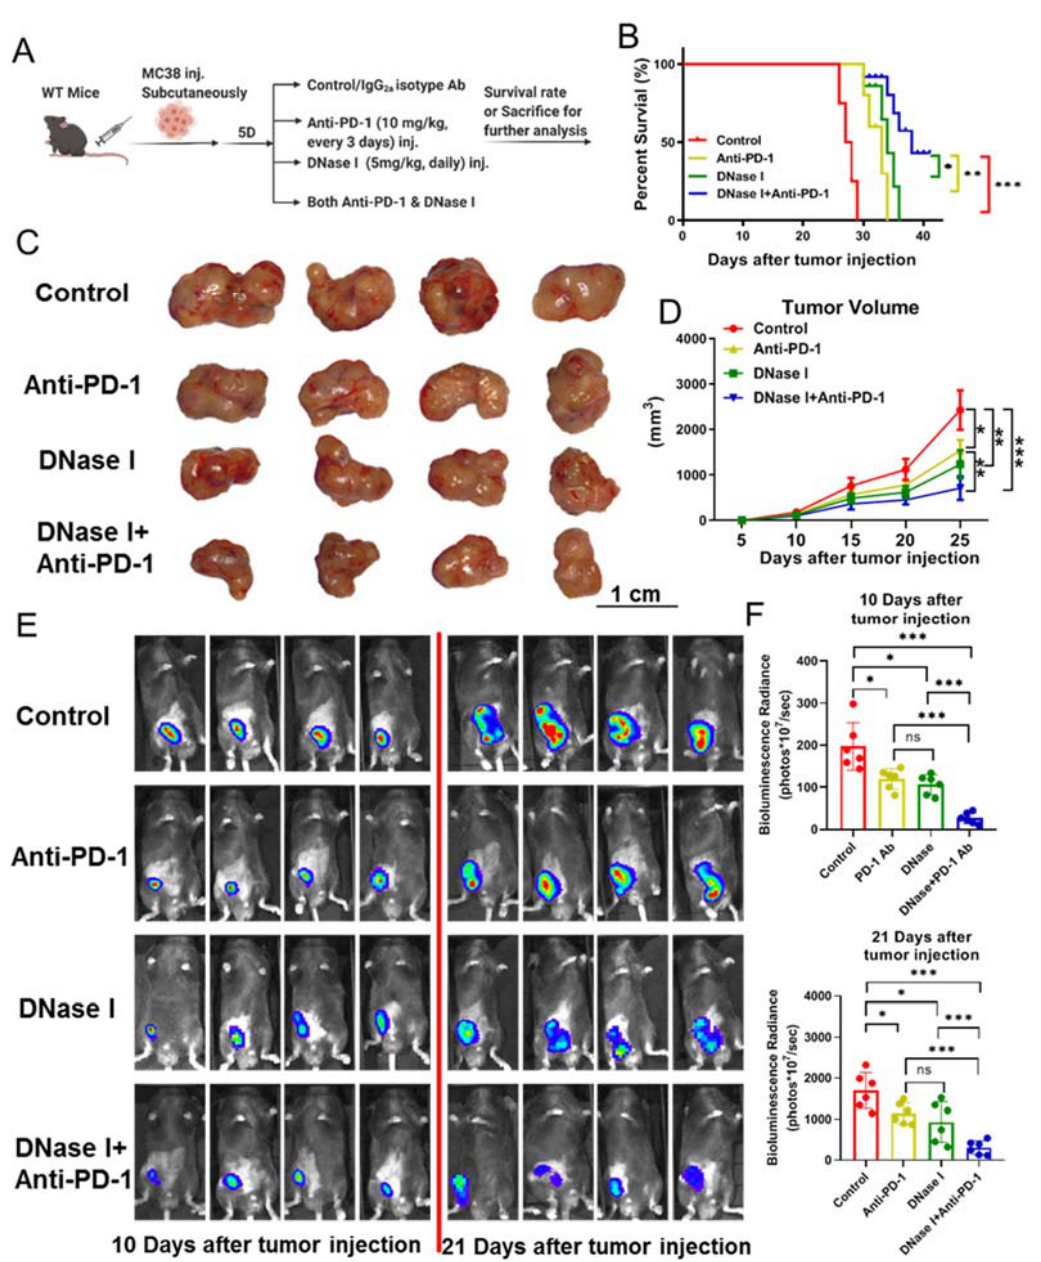
Figure 1. Systemic administration of DNase I improves the efficacy of PD ‐ 1 blockade to reduce the growth of cancer. ( A ) Experiment outline. C57BL/6 male mice received MC38 colorectal cancer cell injection and the mice were treated with IgG2a isotype control, anti ‐ PD ‐ 1, DNase I or anti ‐ PD ‐ 1, and DNase I combination. ( B ) The percentages of overall survival; n = 15 mice/group. ( C ) Representative photograph of flank tumor with different treatments at day 21 after tumor injection. Scale bar = 1cm; n = 6 mice/group. ( D ) Tumor growth curves were established by measuring flank tumors lengthwise and widthwise using the formula (d2 × D)/2 to calculate tumor volume every 2–3 days starting at day 5; n = 6 mice/group. ANOVA with adjustment for multiple comparisons. ( E , F ) The use of luciferase ‐ labeled MC38 cells allowed in vivo tracking of tumor growth with bioluminescence imaging at day 10 and day 21; n = 6 mice/group. Survival curves were analyzed by log ‐ rank (Mantel–Cox) test ( B ). The graphs show the means ± SD ( D , F ). ANOVA was performed with adjustment for multiple comparisons for ( D , F ). Note: * p < 0.05, ** p < 0.01, *** p < 0.001; NS: not significant. All statistical tests used in this figure were two ‐ sided and p < 0.05 was considered statistically significant.